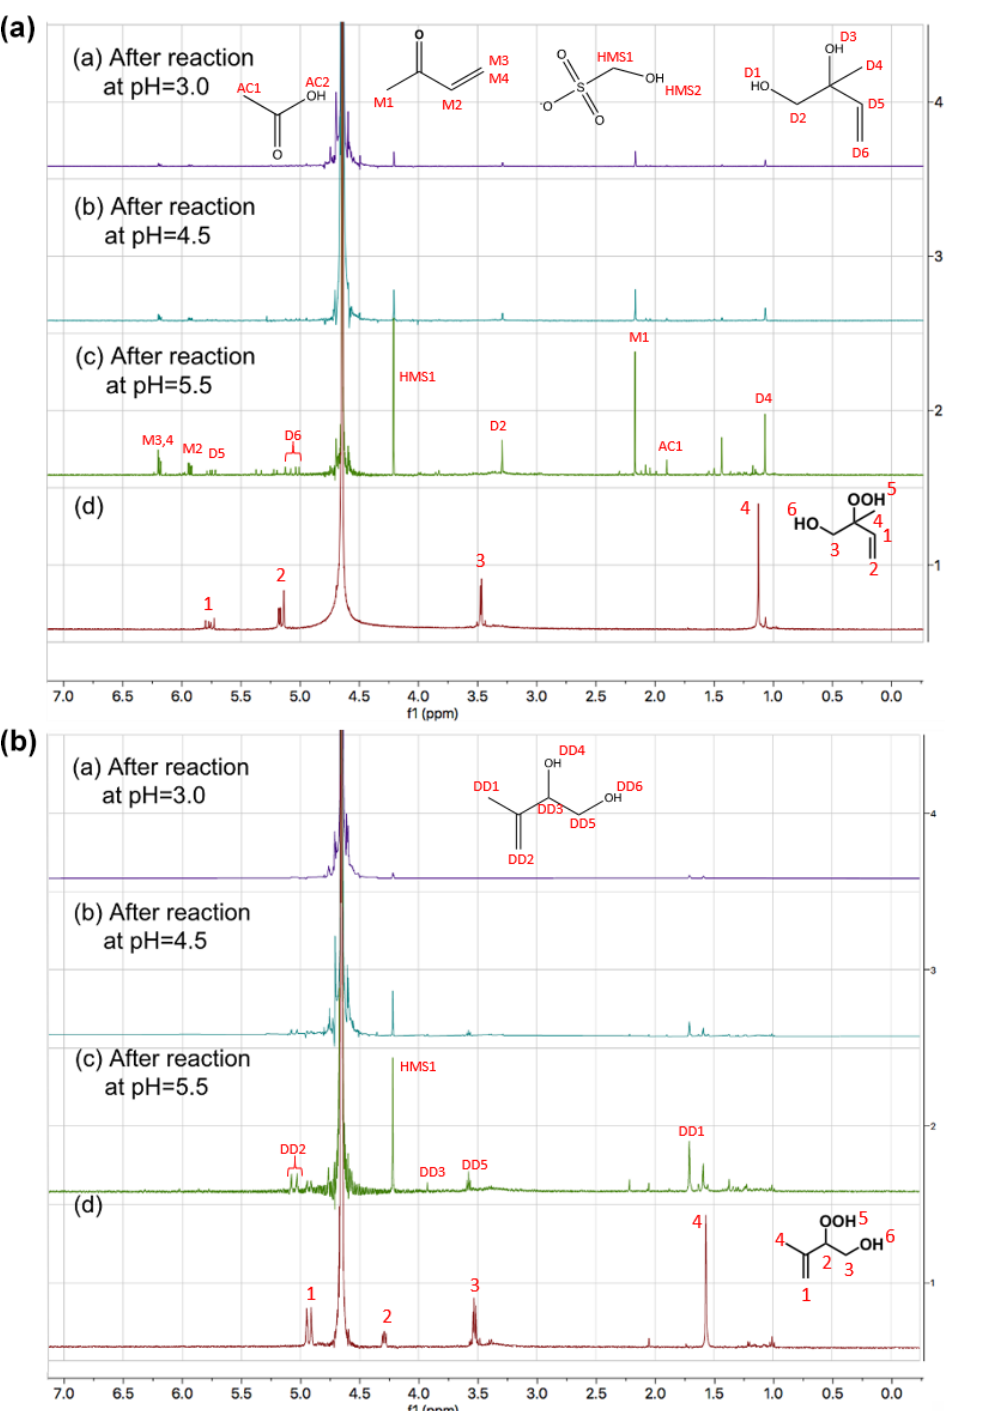
Figure 1. Proton NMR spectra ( 1 H-NMR, 400MHz, D 2 O) of (A) 1,2-ISOPOOH (d) and the products of the reaction of SO 2 , aq + 1,2- ISOPOOH at (a) pH = 3, (b) pH = 4.5 and (c) pH = 5.5 and (B) 4,3-ISOPOOH (d) and the products of the reactions of SO 2 , aq + 4,3- ISOPOOH at (a) pH = 3, (b) pH = 4.5 and (c) pH = 5.5. The concentration of the ISOPOOH isomers was 1mM, and the concentration of SO 2 , aq was 2mM. The spectra are focused on the areas of change. Chemical structures of (a,d) 1,2-ISOPOOH and (b,d) 4,3-ISOPOOH are presented. The labels at each peak represent the hydrogens of the compounds and the spectra are shifted for D 2 O at 4.67ppm.